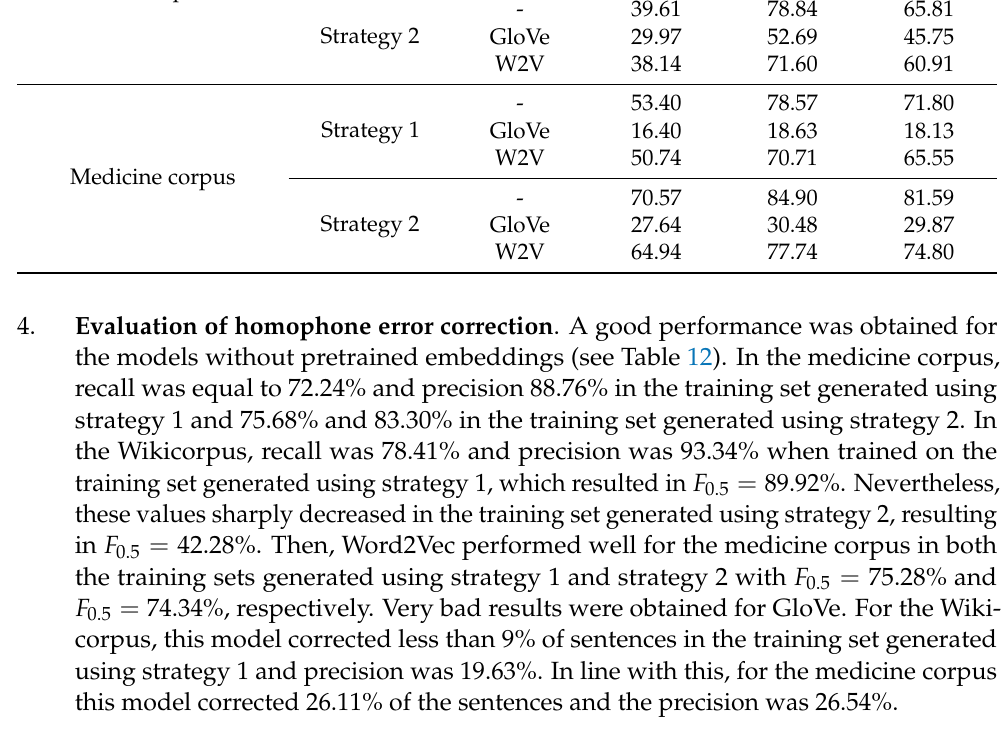
Table 12. Recall ( R ), precision ( P ) and F 0.5 for the evaluation of homophone error correction.